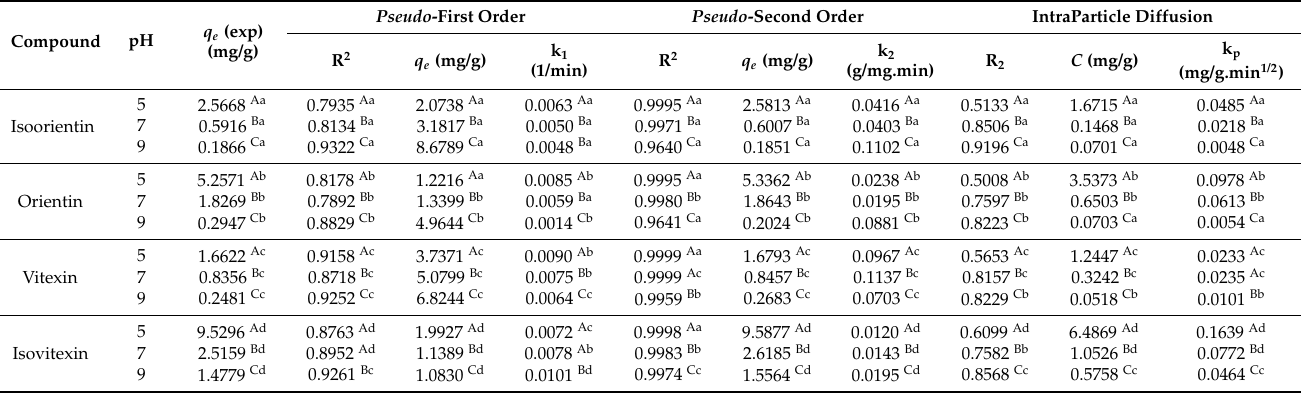
Values marked with different uppercase letters (A–C) indicate a comparison between pH levels for the same compound. Values marked with different lowercase letters (a–d) indicate a comparison between different compounds for the same pH. Each value is the average reading from three replicates (n =